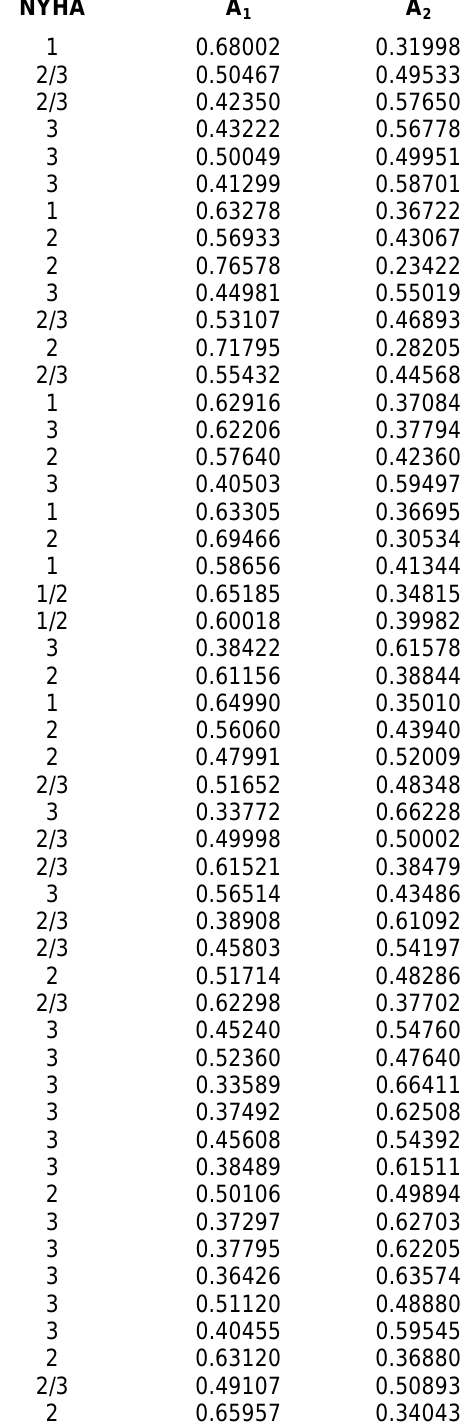
Original Diagnostic and Memberships to the Classes of the Final Fuzzy Partition Produced with Data Normalization (the illnesses order has been established by clinical